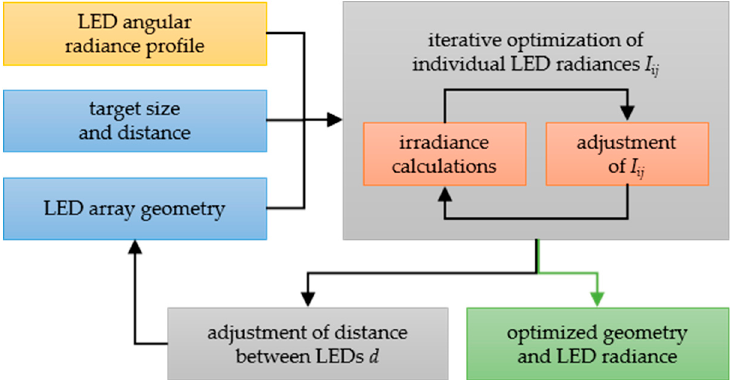
Figure 1. Flowchart showing the main steps of the optimization process. The output (green) is given when either a maximal number of iterations is reached or no better homogeneity is found.